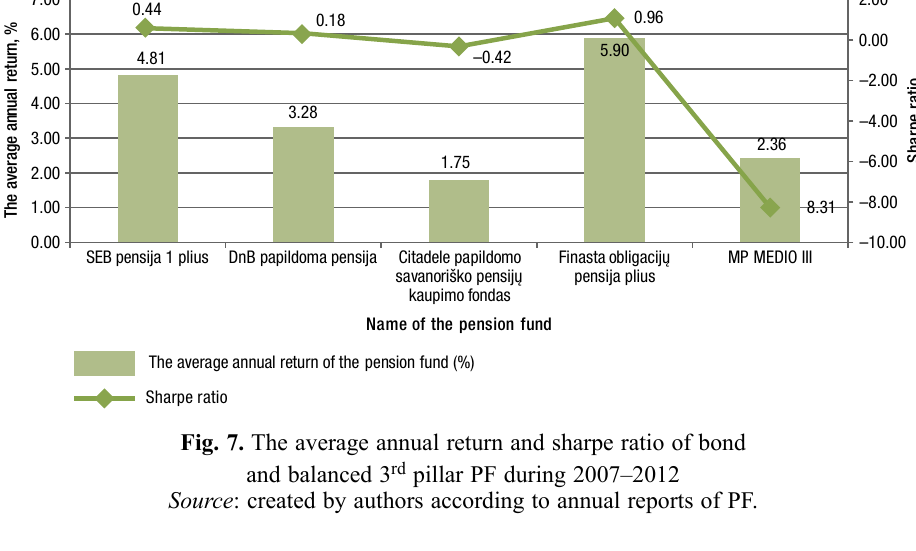
Fig. 7. The average annual return and sharpe ratio of bond and balanced 3 rd pillar PF during